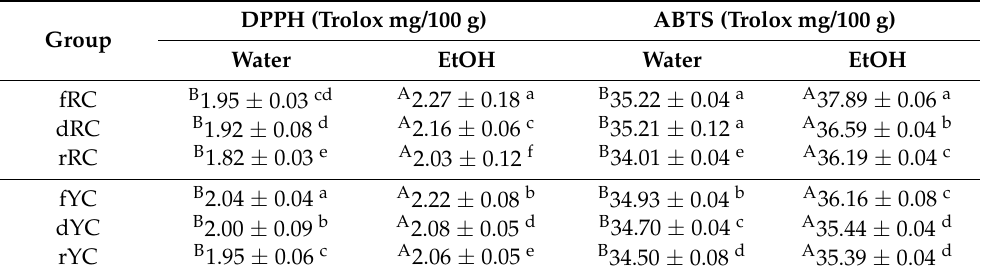
Table 8. Variation of the DPPH and ABTS free radical scavenging capabilities of differently treated polymorphic cacao beans *. DPPH (Trolox mg/100 g) ABTS (Trolox mg/100 Group